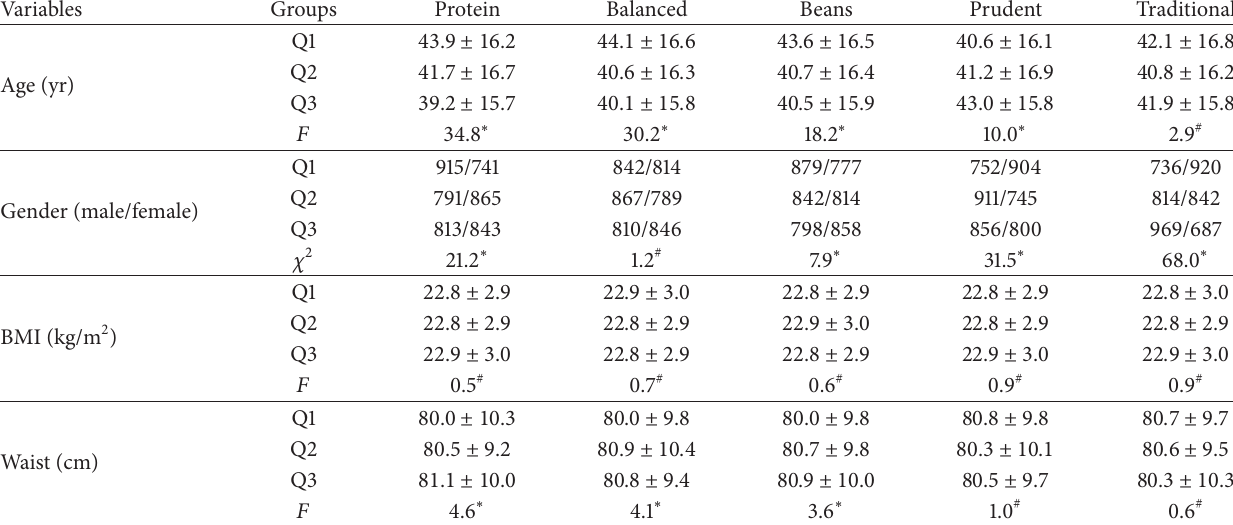
Table 3: Demography and body indices by dietary